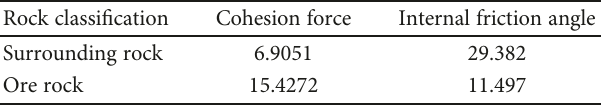
Figure 8: The relationship between the shear stress and the positive stress of ore rock. Table 4: Calculation results of cohesive force and internal friction